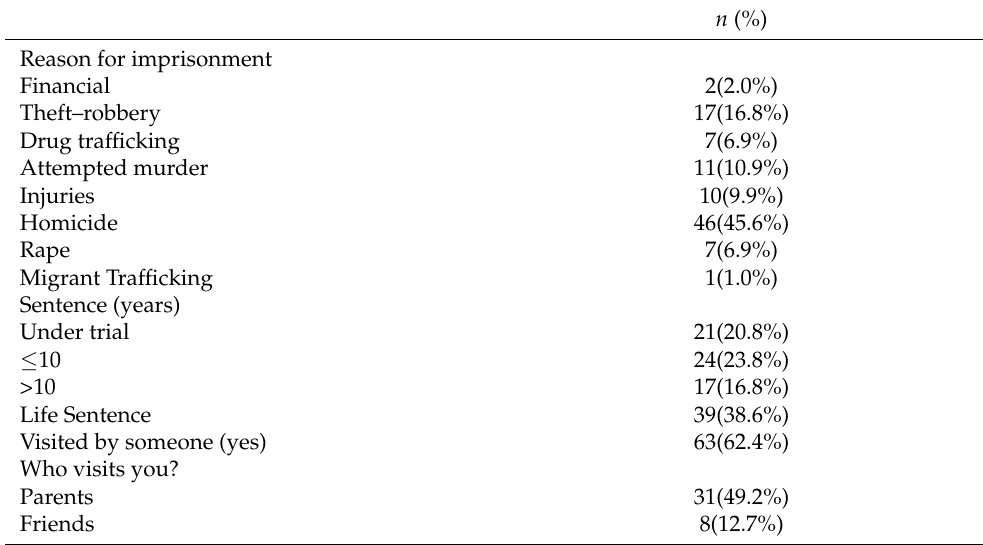
Table 2. Distribution of the sample according to characteristics related to imprisonment ( n =